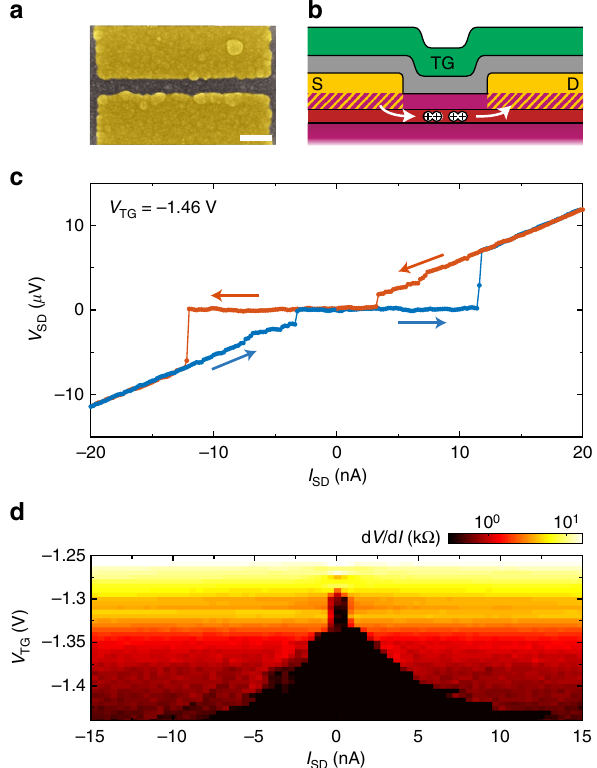
Fig. 5 Tunable induced superconductivity in the Ge quantum well. a SEM image of the JoFET device with a gap of 100 nm. Scale bar is 200 nm. b Device schematic using the colour scheme of Fig. 2b.